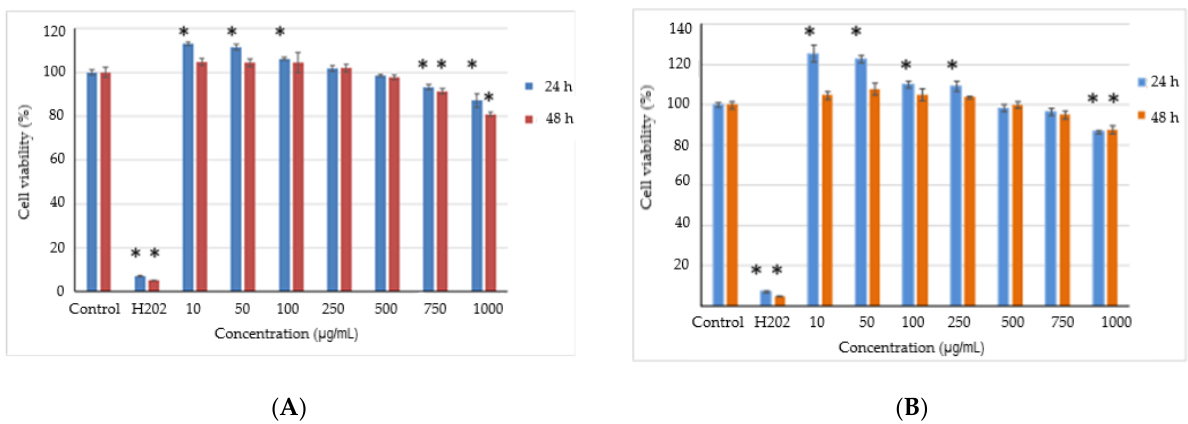
Figure 3. Cell viability of L929 fibroblasts cultivated in the presence of the powders (variant 1 ( A ) and variant 2 ( B ) for 24 h and 48 h, respectively, determined by NR assay. The results were expressed as a percentage relative to the control culture (untreated), considered 100% viable. The values represent mean ± SD ( n = 3). * p < 0.05, compared to the control.